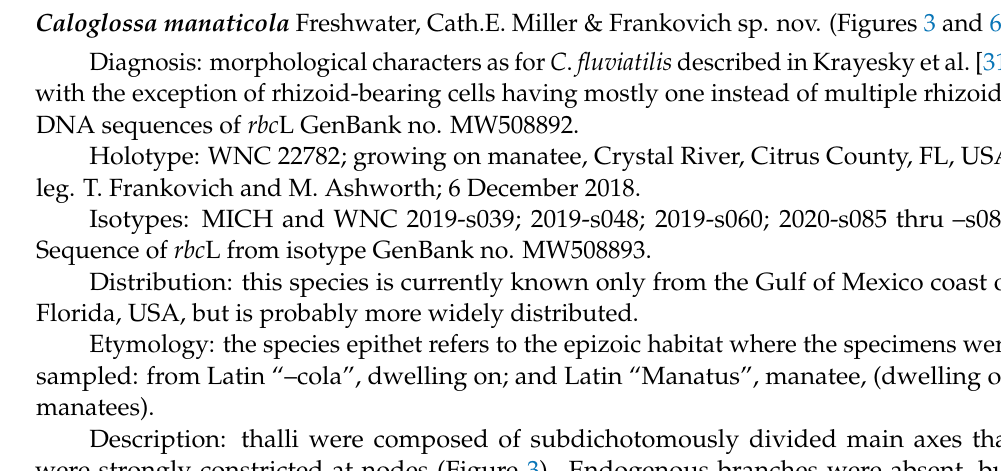
Figure 5. Caloglossa kamiyana sp. nov. ( A ) Tetrasporangial mother cells (T) cut off by oblique divisions of lateral pericentral cells (arrows) and transverse divisions of second- and third-order row cells (arrowheads), scale = 50 µm. ( B ) Tetrasporangia cut off from lateral pericentral cells (arrows), second- and third-order row cells (arrowheads), scale = 50 µm.